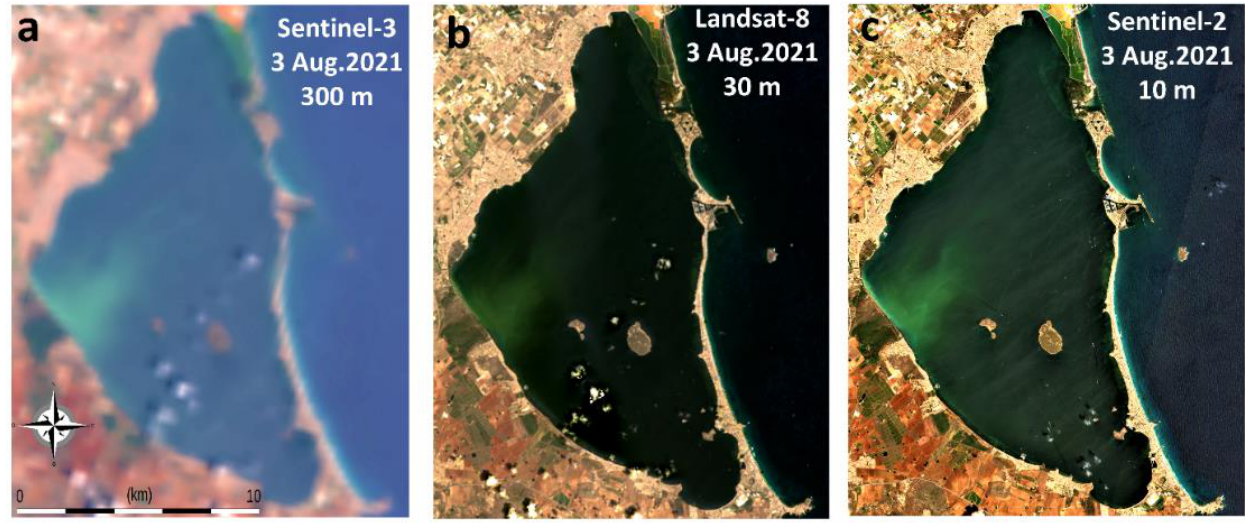
Figure 4. RGB (Red–Green–Blue) composite image on 3 August 2021 of ( a ) Sentinel-3 satellite (300 m spatial resolution), ( b ) Landsat-8 satellite (30 m spatial resolution), and ( c ) Sentinel-2 satellite (10 m spatial resolution).